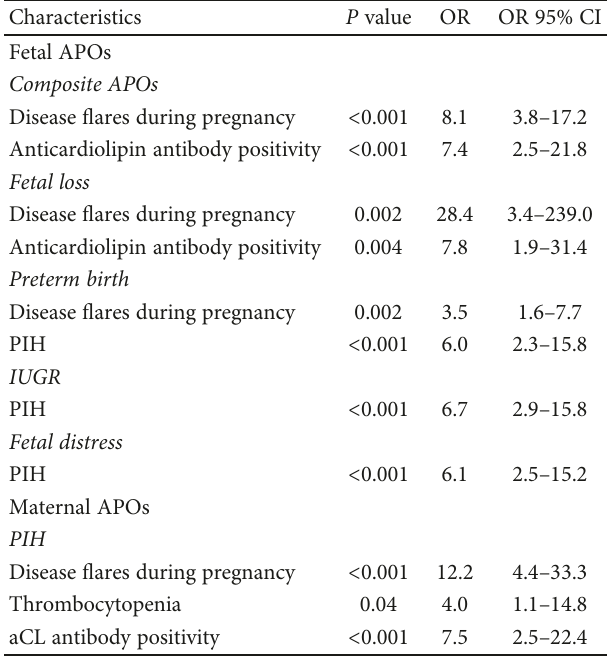
Table 3: Association of di ff erent characteristics during pregnancy with APOs: results of multivariate